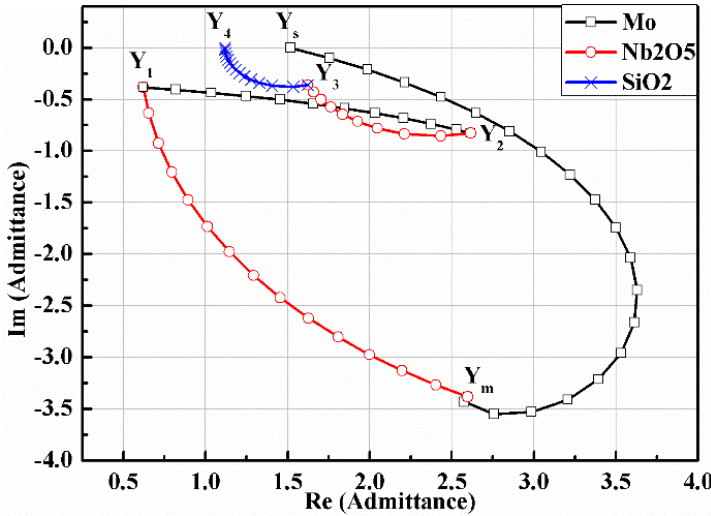
Figure 11. Admittance loci at 550 nm of optimization solar selective absorber.